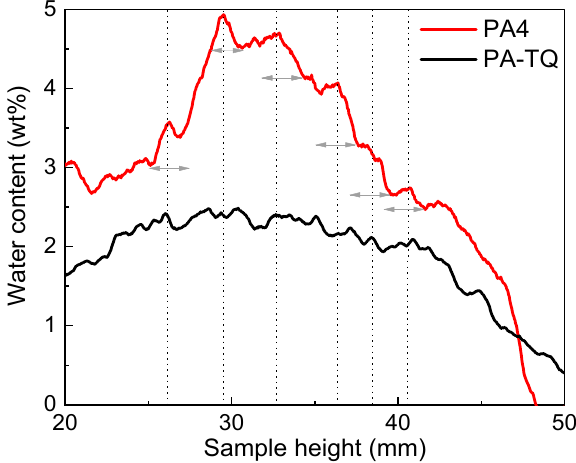
Figure 8. Water content profiles for samples PA4 (NL consolidated) and PA-TQ (reference) between 20 and 50 mm. Dotted lines mark peaks which reveal, better than others, the enlargement induced by the thenardite–mirabilite phase transition activated by microclimatic stimuli (T/RH jumps).